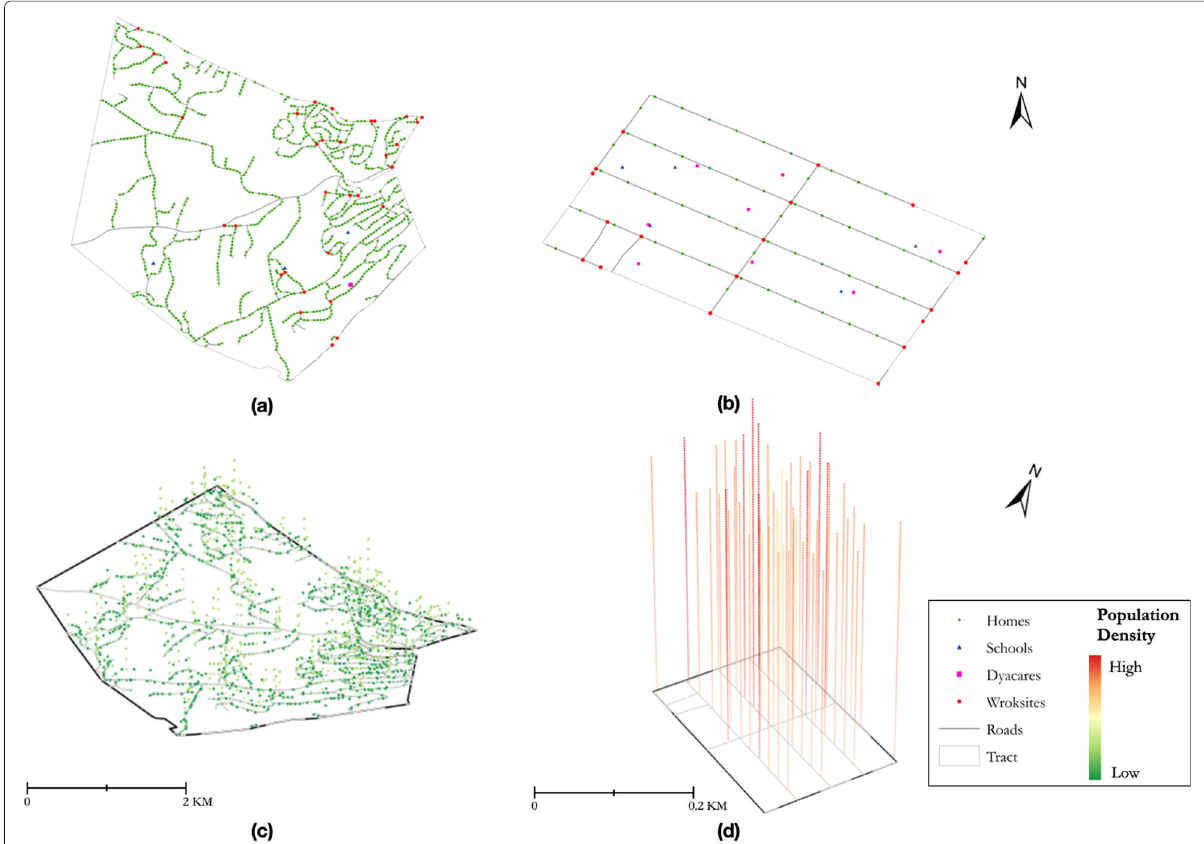
Fig. 3 ( a ) Suburban Area: Mapped locations for Census Tract 34027043402, NJ: ; ( b ) High Density Urban Area: Mapped locations for Census Tract 36061017700, NY; ( c ) Suburban Area: Population Density; ( d ) High Density Urban Area: Population